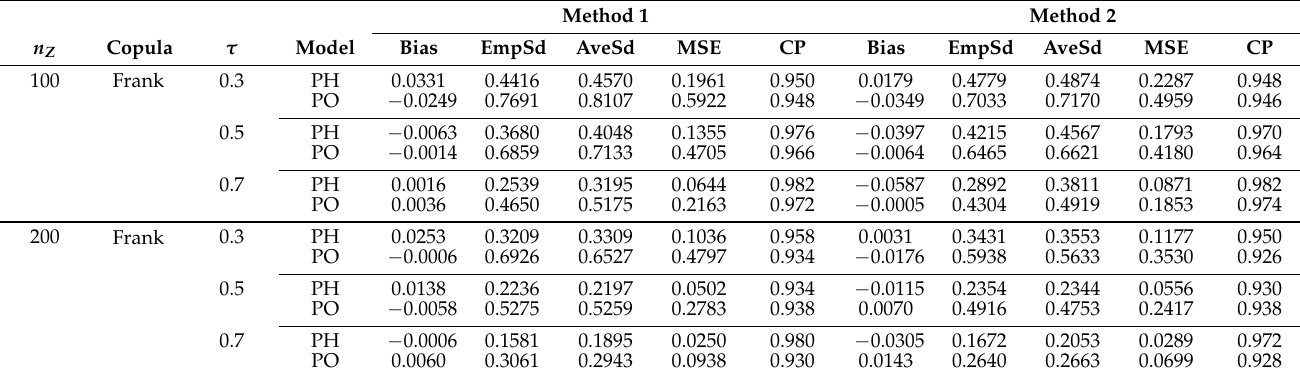
Table 6. The estimators of θ under Case 1 when the variable of interest is